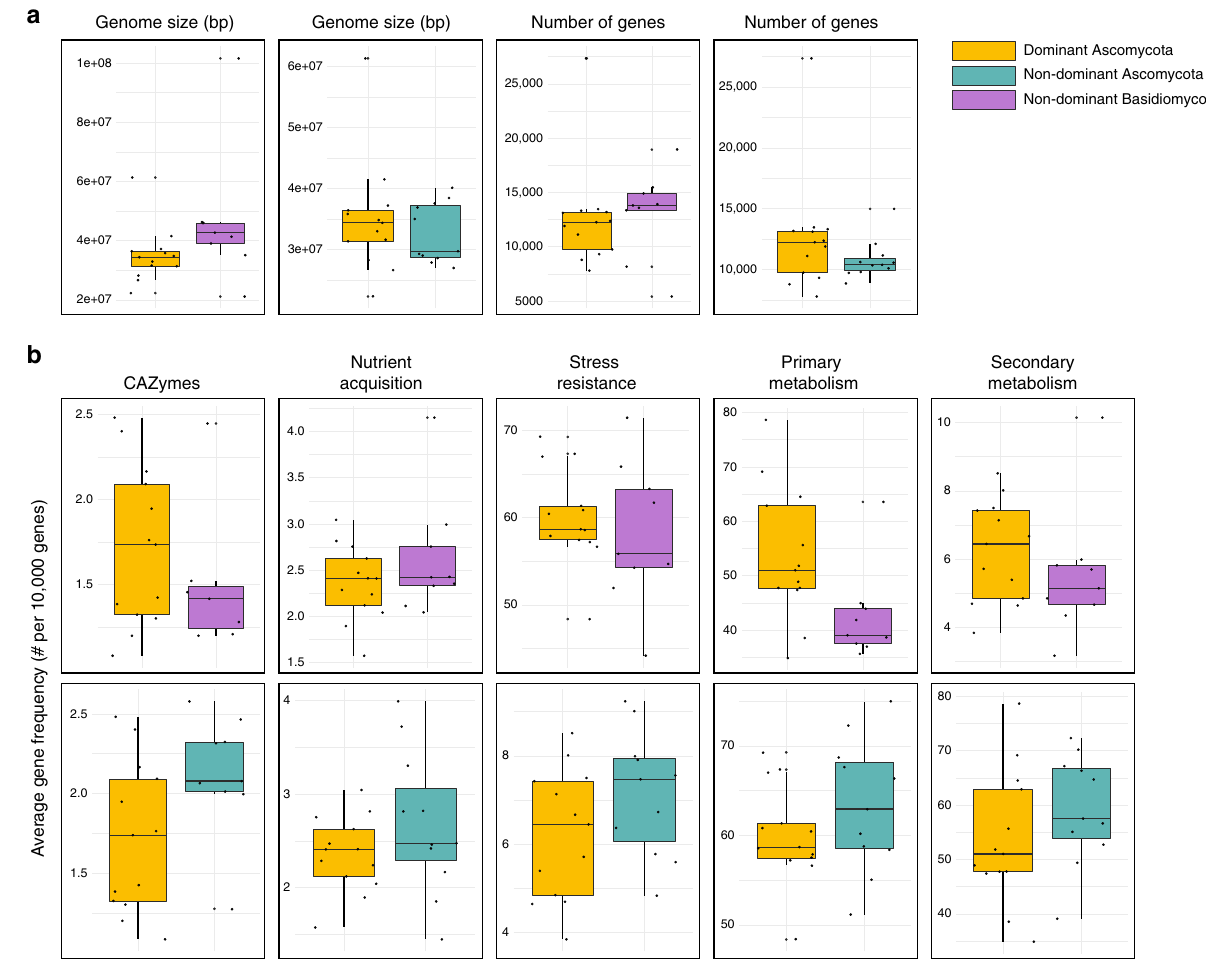
Fig. 3 Differences in abundance and occurrence of the functional genes across phyla. a Boxplots showing the average genome sizes and number of putative genes of the dominant Ascomycota ( n = 13) compared with non-dominant Basidiomycota ( n = 9), and dominant Ascomycota compared with non- dominant Ascomycota ( n = 11) representatives. b Boxplots showing the average relative frequency of gene classes associated with different ecological traits in dominant Ascomycota vs. non-dominant Basidiomycota (upper row), and dominant Ascomycota vs. non-dominant Ascomycota (lower row). Source data are provided as a Source Data fi